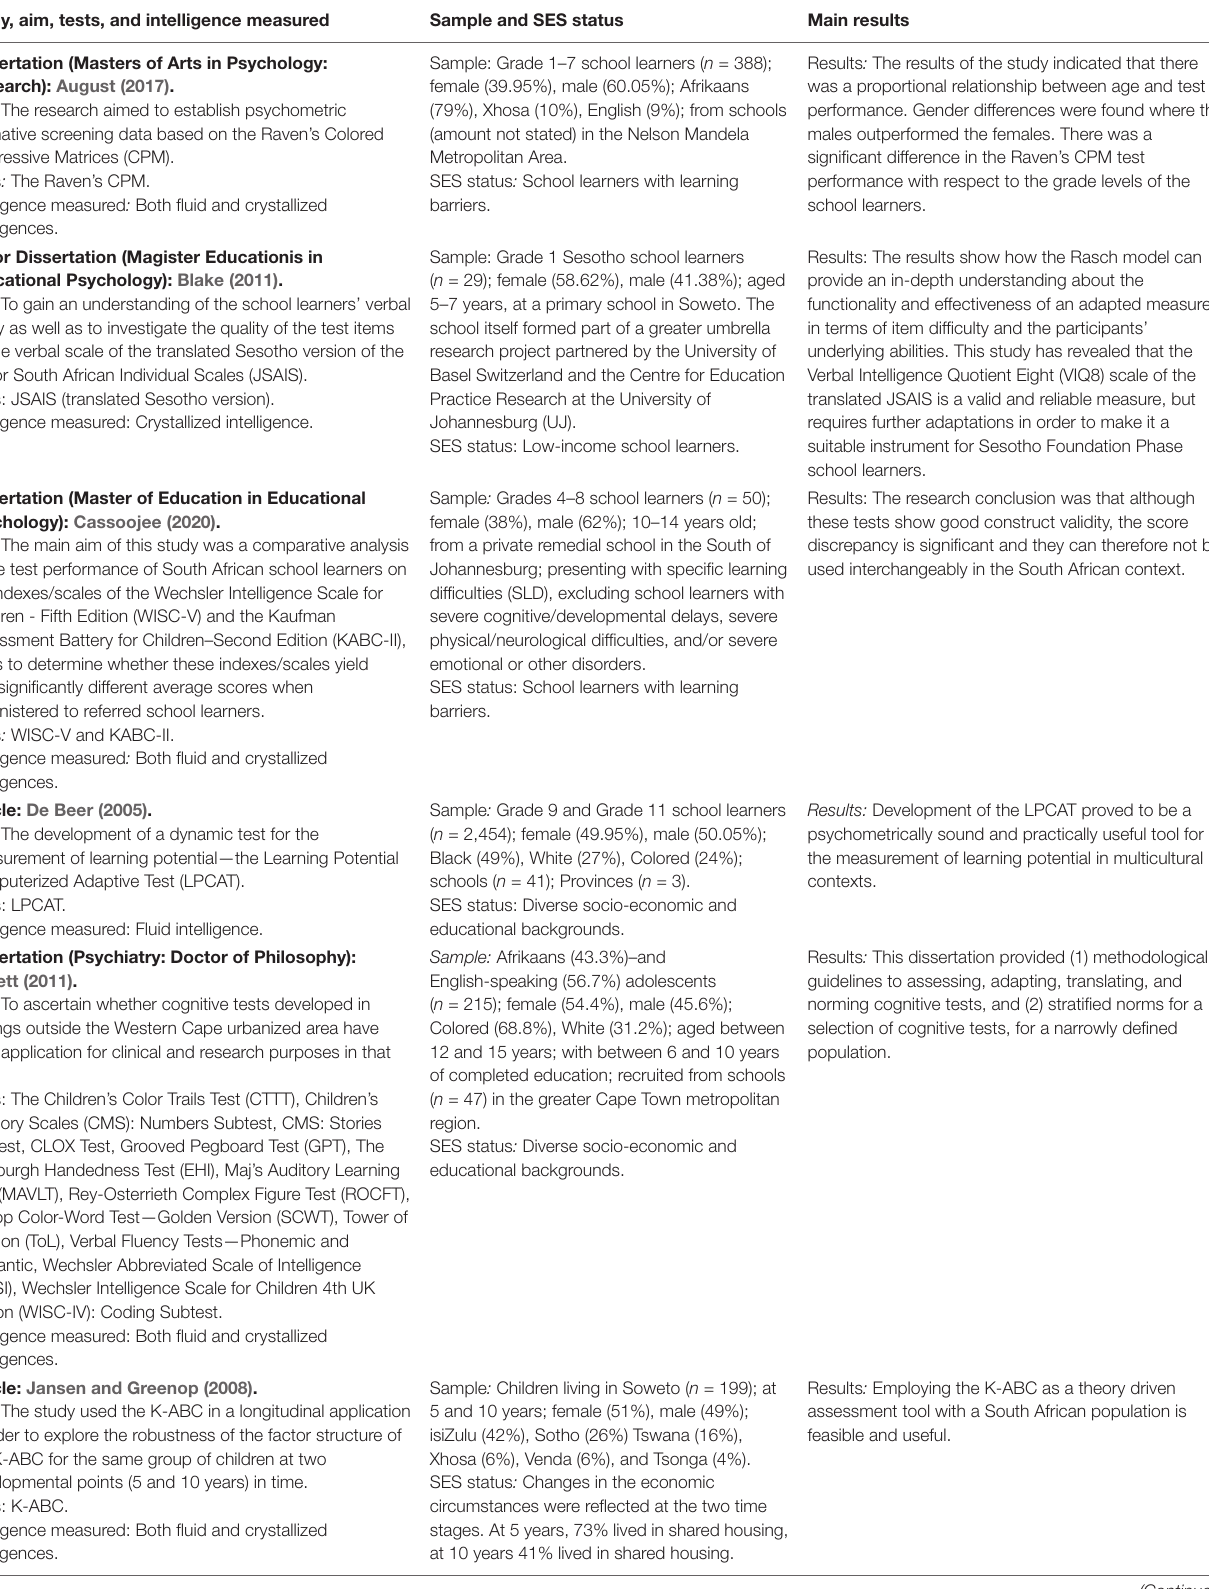
TABLE 1 | Data extraction